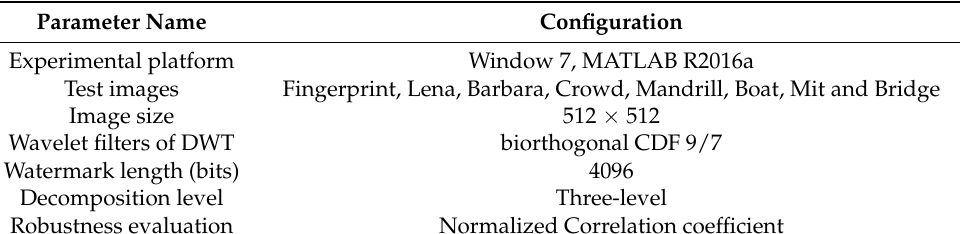
Table 1. Experimental parameter settings.